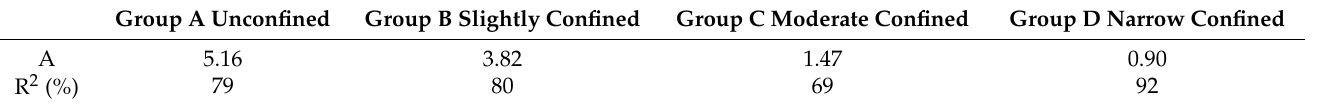
Figure 8. Extracted exponential fitting curves of bond loss as a function of corrosion penetration depth, for each confinement level group. ( a ) Unconfined specimens, ( b ) Slightly confined specimens, ( c ) Moderate confined specimens, ( d ) Narrow confined specimens.